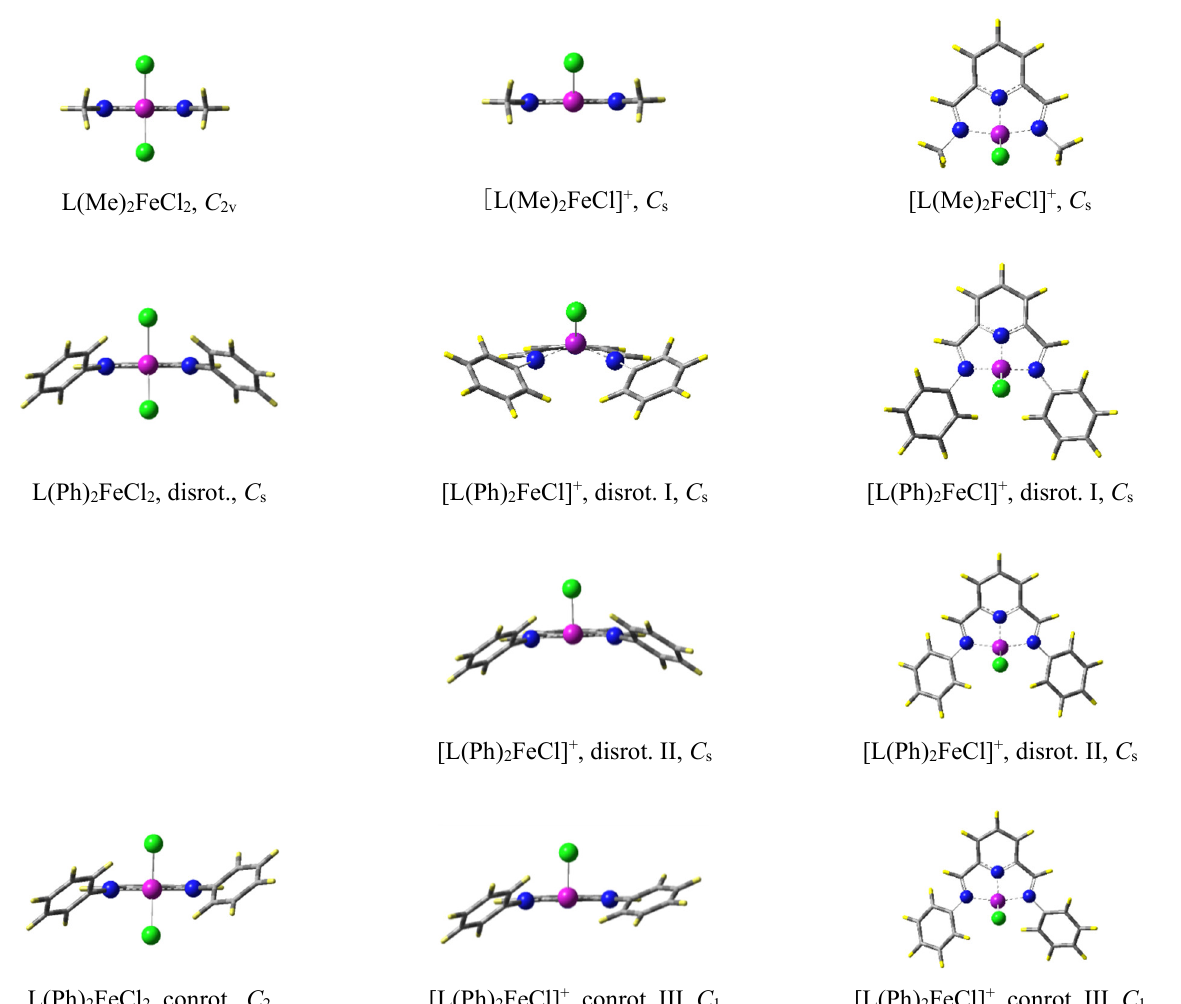
+ are shown in the other two 2 FeCl]